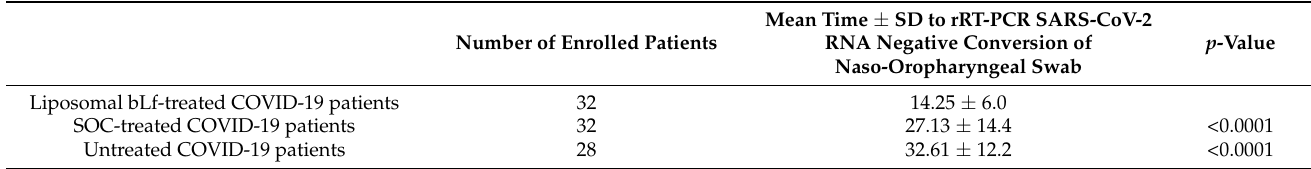
Table 2. Mean time and standard deviation (SD) to reverse transcriptase real time (rRT)-PCR SARS-CoV-2 RNA negative conversion in liposomal bovine lactoferrin (bLf)-treated, standard of care (SOC)-treated, or untreated COVID-19